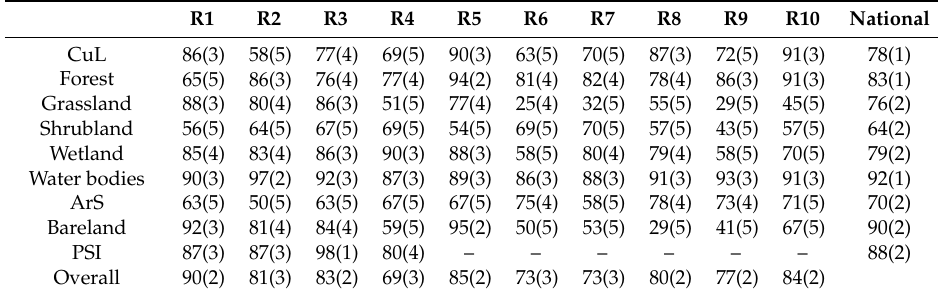
Table A11. Regional user’s accuracies for nine land cover classes with standard errors (SE) in parentheses when agreement is defined as a match with the primary label.